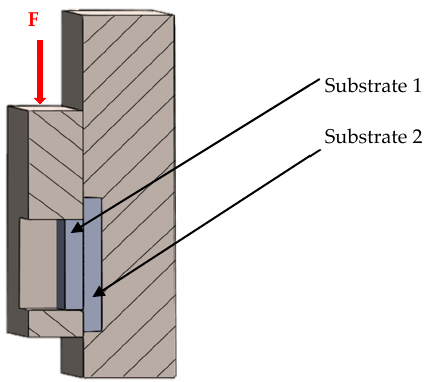
Figure 3. Schematic representation of the jig for shear strength measurement.